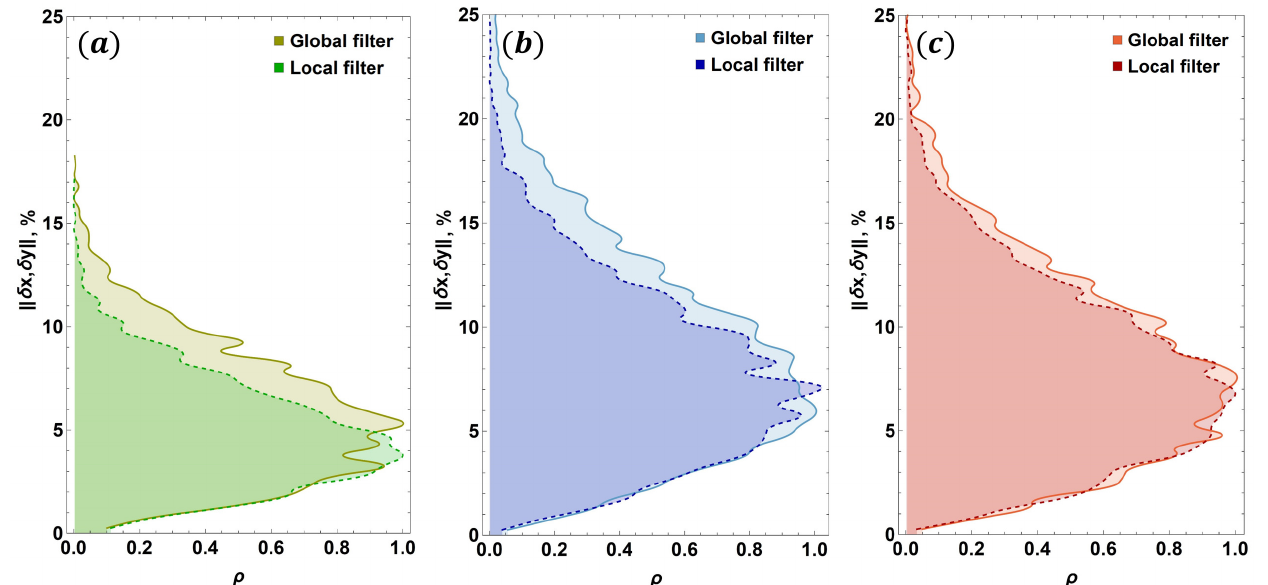
Figure 26. Static reference body: smooth normalized (cid:107) δ x , δ y (cid:107) histograms for neutron flux transmission along the ( a ) smaller axis, ( b ) larger axis and ( c ) larger axis with an extra 1 cm distance between the scintillator and the body. Note that here δ x ≈ δ y for all instances, which is why they are not plotted